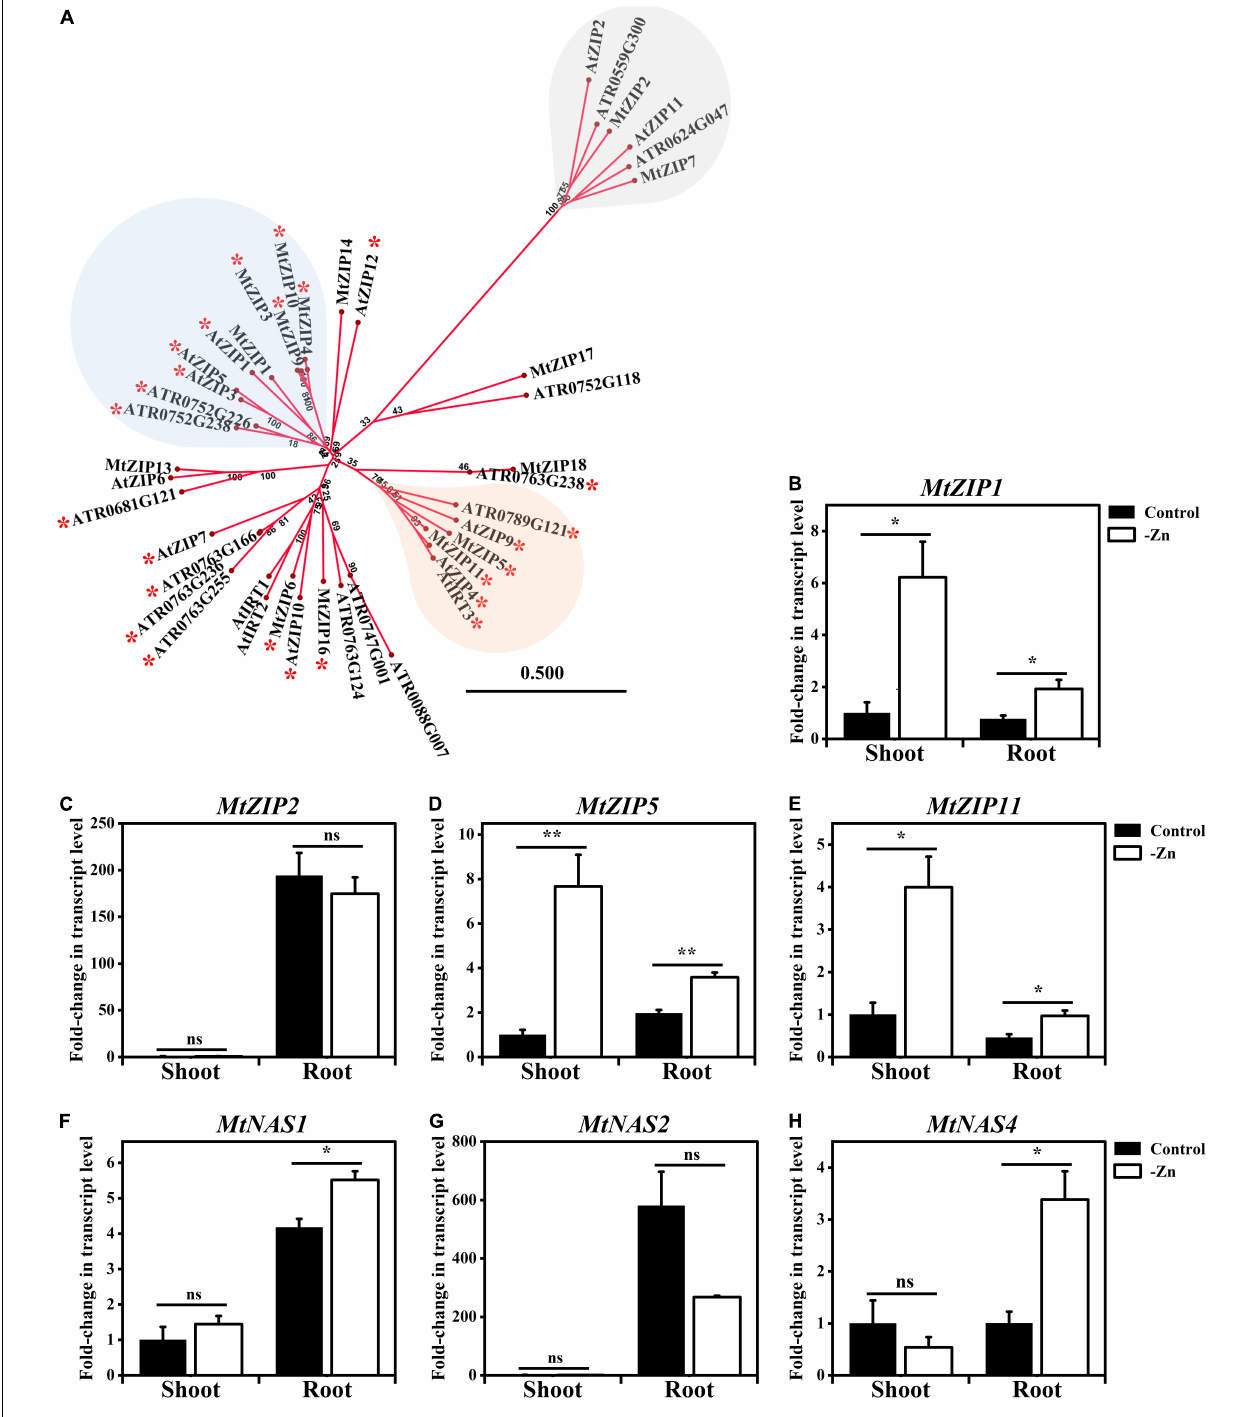
FIGURE 5 | Analysis of M. truncatula ZIP and NAS family members. (A) Phylogenetic tree of M. truncatula (Mt), Arabidopsis (At) and A. trichopoda (ATR) ZIP transporters. Branch lengths are proportional to phylogenetic distance. Numbers on each branch represent the percentages of bootstrap. An asterisk (*) next to a ZIP transporter gene ID means that one or more ZDRE motifs were detected in the gene promoter ( Supplementary Table 2 ). The orange, blue and gray shadows highlight different clades of the phylogenetic tree. (B–H) Gene expression analysis of 4-week-old M. truncatula plants grown on sand watered with Zn sufficient (Control) or Zn deficient (–Zn) nutrient solution. Shoot and root transcript level of (B) MtZIP1 , (C) MtZIP2 , (D) MtZIP5 , (E) MtZIP11 , (F) MtNAS1 , (G) MtNAS2 , and (H) MtNAS4 . Data represent mean fold-change in transcript level ± SE (n = 3 biological replicates). Significant differences between control and –Zn treatments were determined by Student’s t -test (* p < 0.05, ** p < 0.01, ns means not significant).